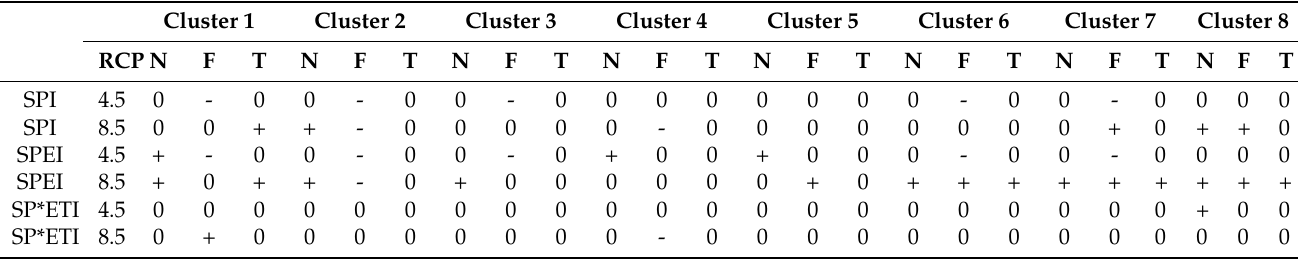
Table 4. The results of the modified Mann–Kendall test of the drought area ratio of clusters. The indicators “+”, “0”, and “-” represent a significantly increasing trend, no significant trend, and a significantly decreasing trend, respectively. N represents NF (2021–2050), F represents FF (2071–2100), and T represents Total Future (TF, 2006–2100).